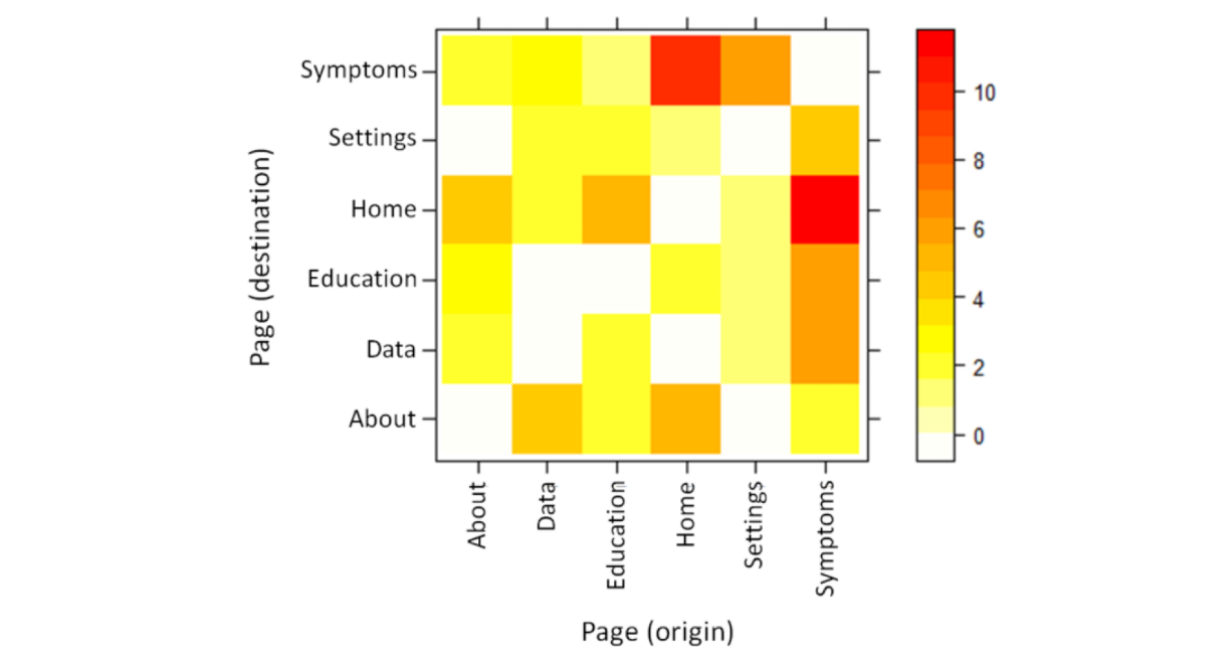
Figure 9. Most common sequence of events within an episode between